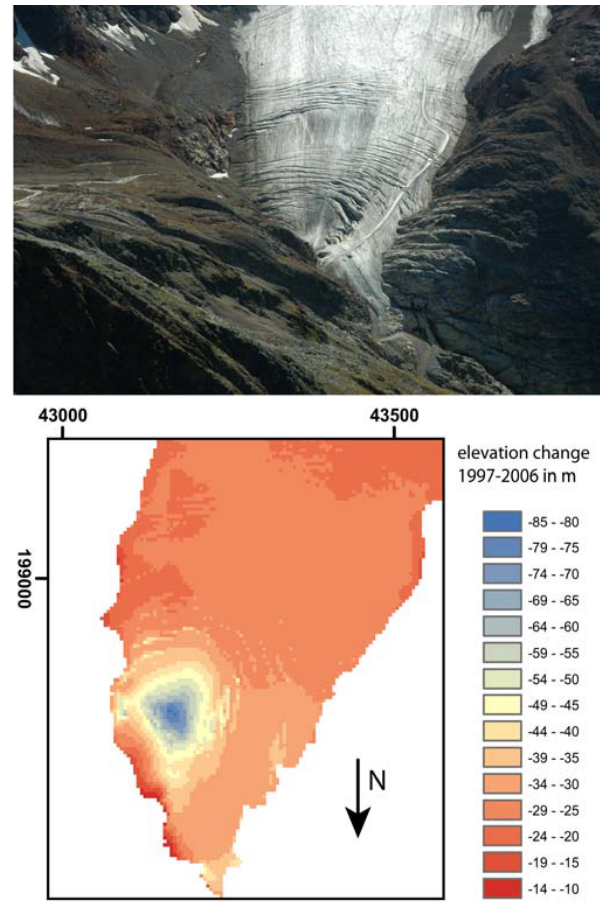
Fig. 16. Radial crevasses and subsidence zone at the tongue of Mit- telbergferner in 2006 and the surface elevation change in m between 1997 and